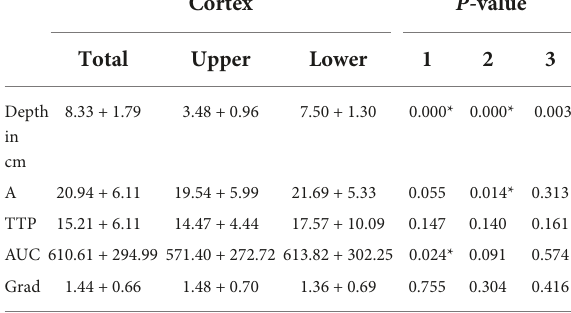
p-value group: 1 = upper vs. total. 2 = upper vs. lower 3 = total vs. lower; A, AUC, Grad ina.u.;TTPinseconds. *p<0.05. TABLE 7 Differences of TIC parameters between operators 1 and 2.